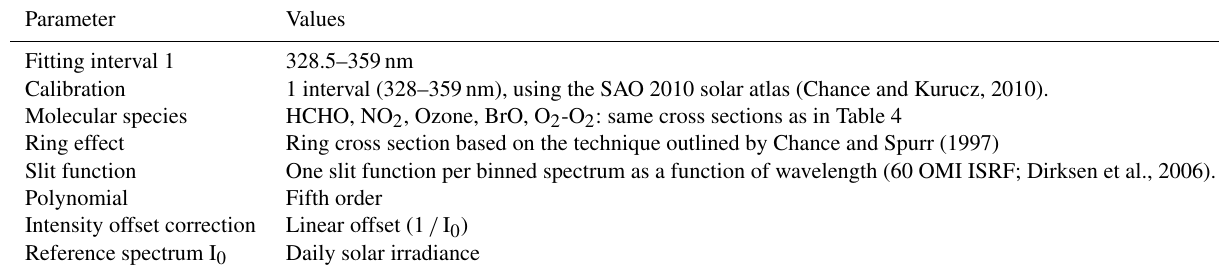
Table 11. Common DOAS fit settings for HCHO using OMI